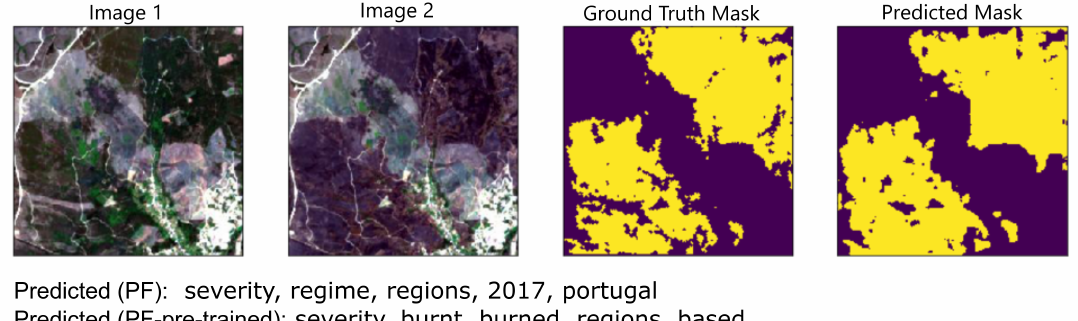
Figure 4. An image pair with its ground truth mask and the mask predicted by the change detection model (Section 3.1) along with the top five annotations predicted by three models. The results from the models trained on PF without pre- training, PF under the change detection pre-training strategy and Forest aligned with PF are